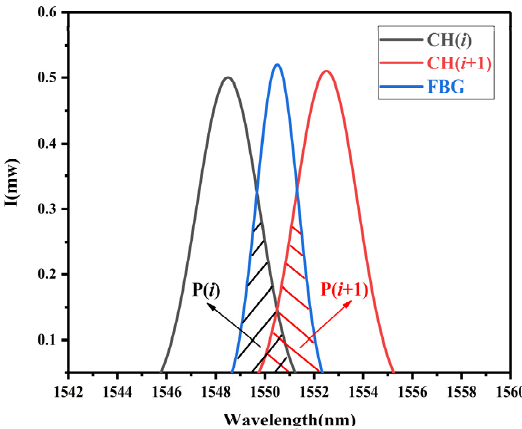
Figure 1. Schematic diagram of the AWG interrogation system.